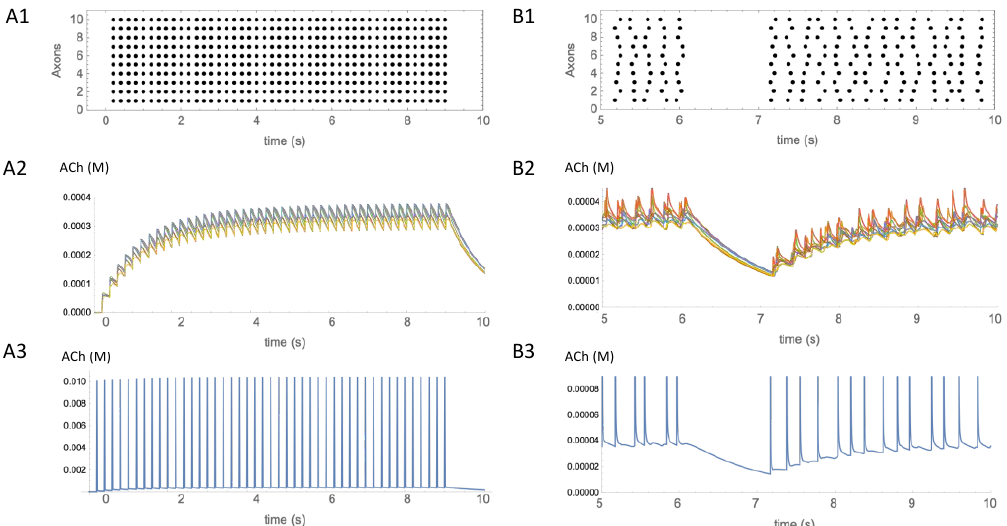
Figure 4. Temporal aspects of ACh signaling. ( A1 ) Regular synchronous activation at 5 Hz of 10 axons activated 5000 release sites in the same 50 × 50 × 50 µ m volume as shown in Figure 3. Activity started at t = 0 s and continued for 9 s. ( A2 ) Estimated concentration of ACh produced by the activity shown in ( A1 ). Eight traces showing time course of ACh concentration changes from different observation points in the volume are overlaid. ( A3 ) Single trace from an observation point adjacent to a release site, showing the transient increases in ACh at that location. ( B1 ) Irregular asynchronous activity at 5 Hz was paused from 6–7s. ( B2 ) Eight traces are overlaid showing time course of ACh concentration changes from different observation points in the volume. ( B3 ) Single trace from the observation point adjacent to a release site, showing the transient increases in ACh at that location. Transients have the same amplitude as in ( A3 ), but have been truncated so that low concentration changes can also be